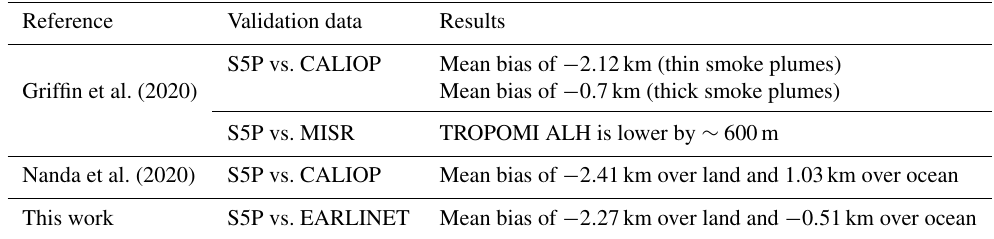
Table 6. Summary of validation statistics for TROPOMI ALH using the O2A